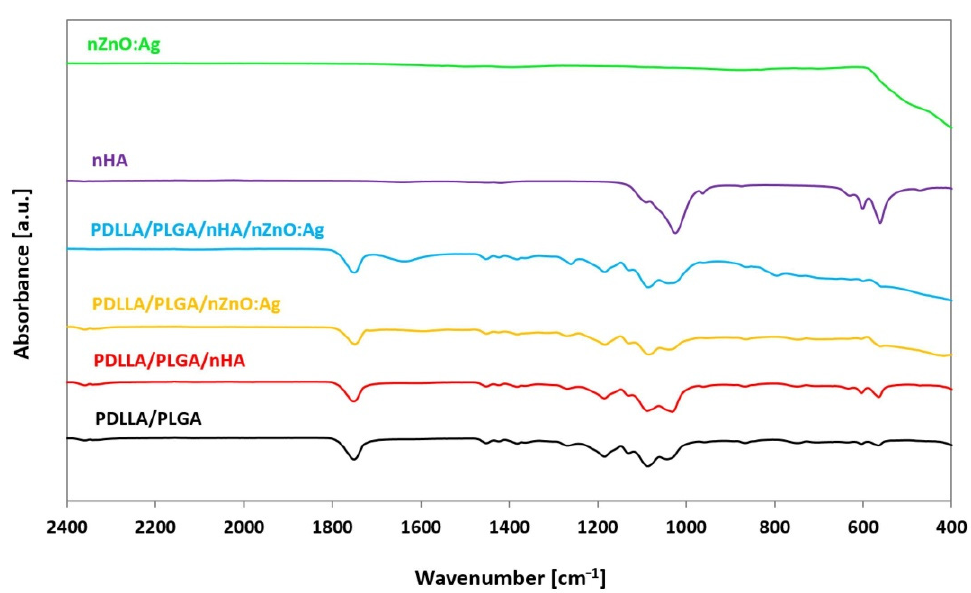
Figure 5. FTIR spectra of synthesized nanopowders (nHA, nZnO:Ag, electrospun polymer blend), PDLLA/PLGA, and sonocoated samples (PDLLA/PLGA/nHA, PDLLA/PLGA/nZnO:Ag, and PDLLA/PLGA/nHA/ZnO:Ag).